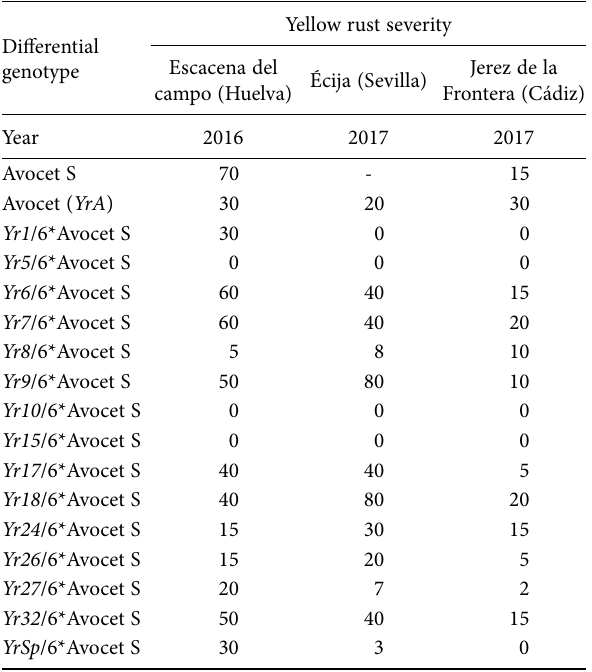
Table 3. Severity of yellow rust ( Puccinia striiformis ) on the Avocet bread wheat near–isogenic differential, set at three locations in the Guadalquivir basin of Andalusia during 2016 and